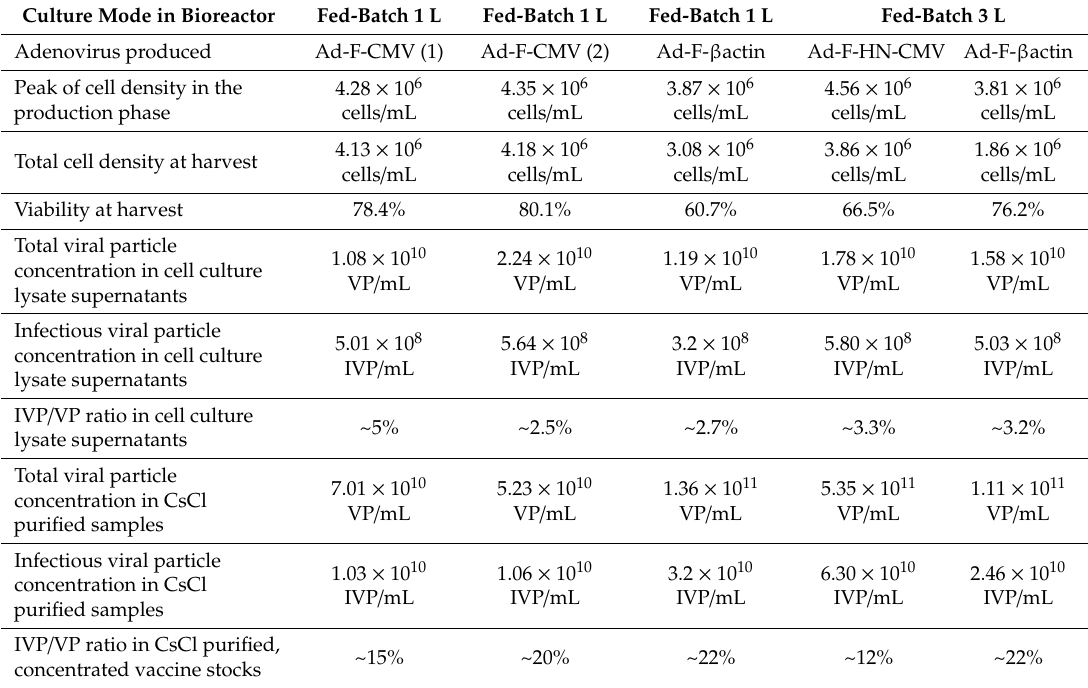
Table 2. Summary of key process data and recombinant adenovirus productivity in the 1 L and 3 L bioreactors operated under fed-batch culture